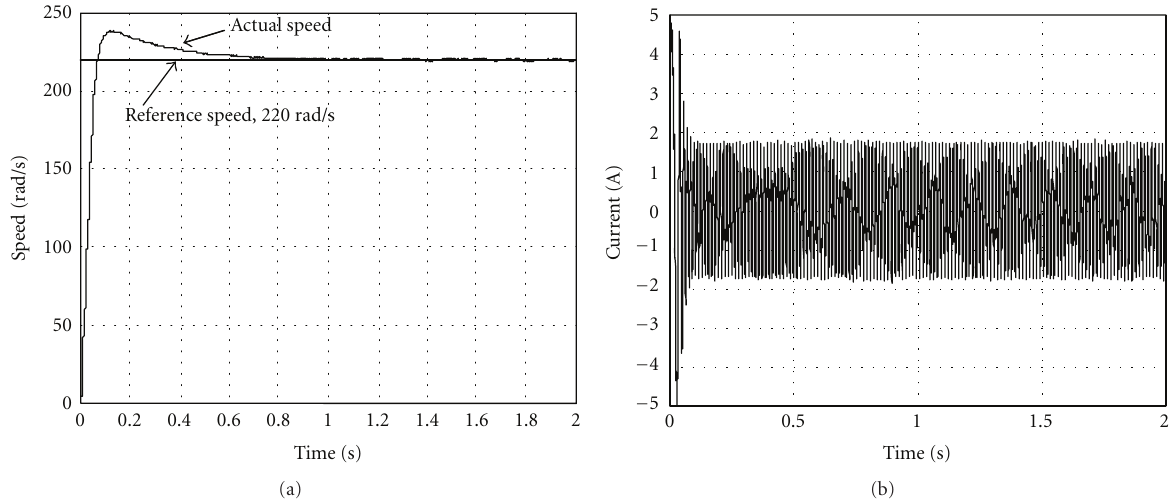
Figure 5: (a) Simulated speed of IPMSM drive for flux-weakening control with reference speed 220 rad/s using PI controller. (b) Simulated current of IPMSM drive for flux-weakening control with reference speed 220rad/s using PI controller.